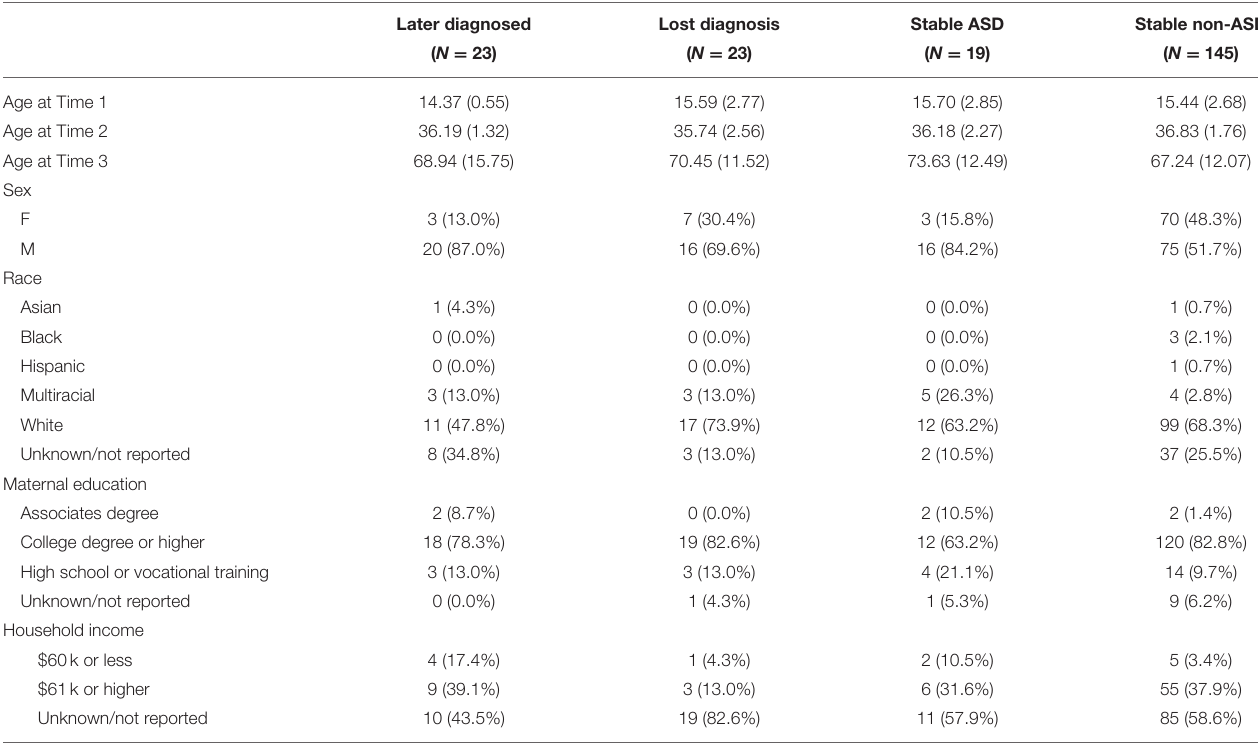
TABLE 1 | Participant characteristics.